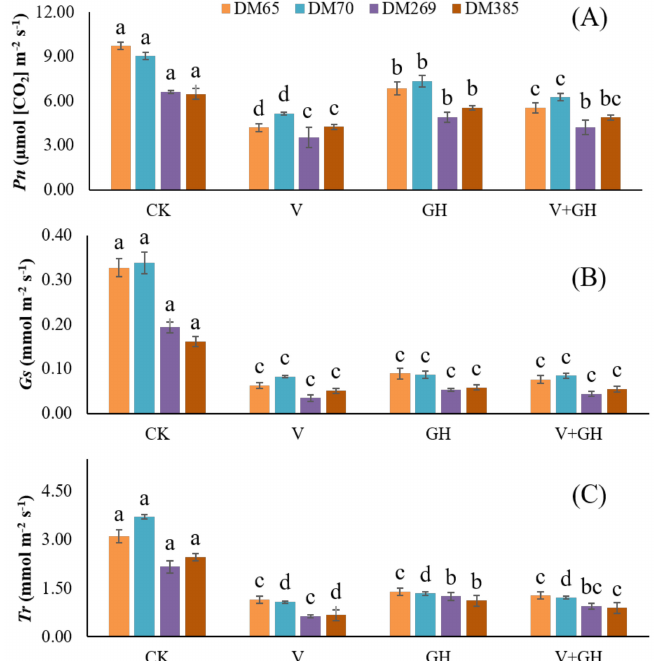
Figure 2. Effects of vernalized and greenhouse environments on the physiology of four barely geno- types ( n = 5). ( A ) Net photosynthesis rate ( Pn ), ( B ) stomatal conductance ( Gs ), and ( C ) transpiration rate ( Tr ). Legends: control (CK), vernalization (V), greenhouse (GH), and moved from vernalization to the greenhouse (V + GH). Vertical bars correspond to means ± SE. Different letters indicate a significant difference at p ≤ 0.05 within the genotypes and among the